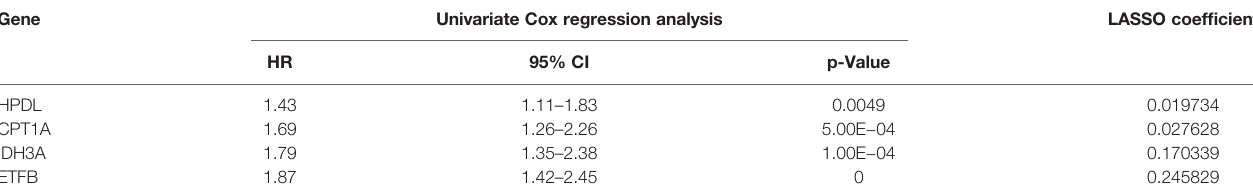
TABLE 2 | The MRGs in the prognostic classi fi er. Gene Univariate Cox regression analysis